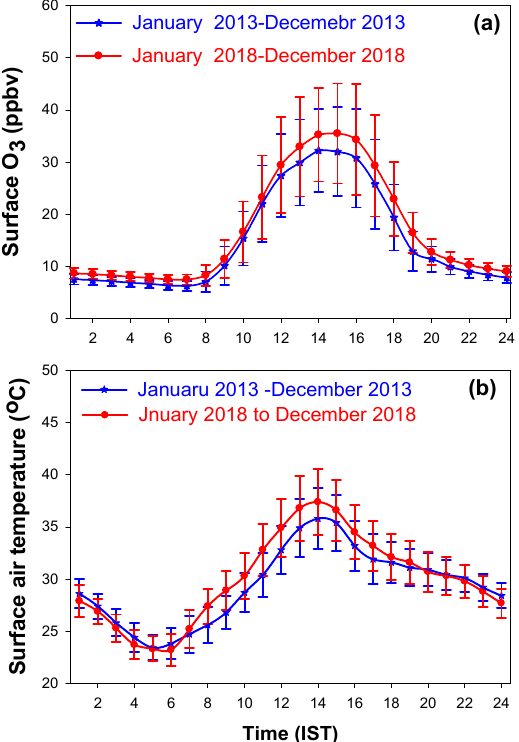
Figure 7. Annual mean 24-h variations of ( a ) O 3 and (b) surface air temperature for the years 2013 and 2018.